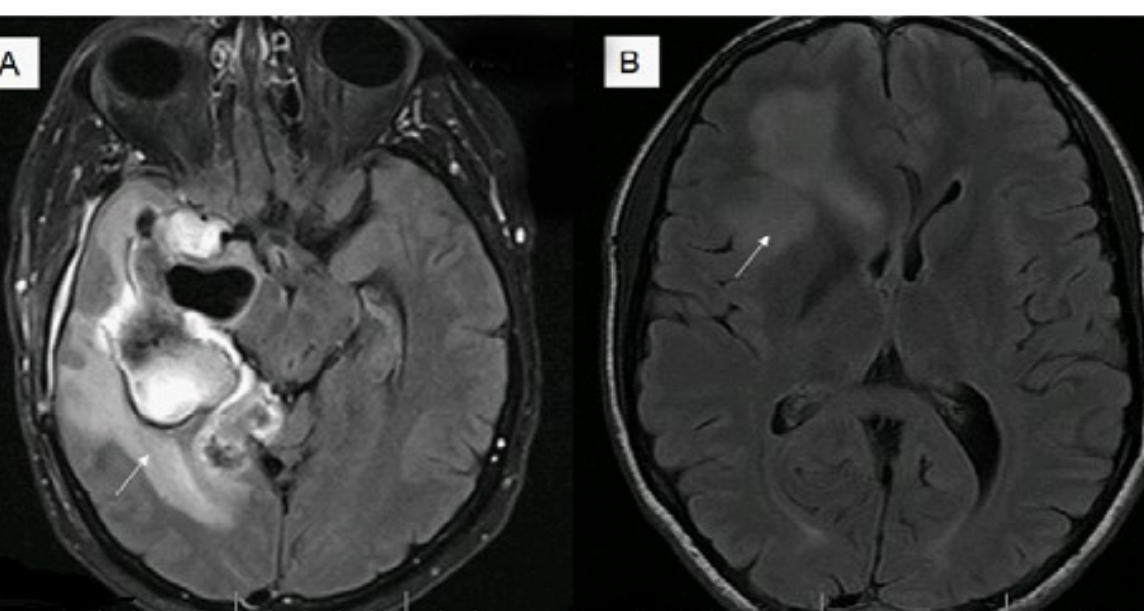
Figure 1. Magnetic resonance fluid attenuation inversion recovery (FLAIR) T2 imaging ( A ) of a 39 year old male, O(6)-methlyguanine-DNA-methyltransferase (MGMT) methylated glioblastoma (GBM) with increased edema (survival eight months post diagnosis); ( B ) 32 year old male, MGMT methylated GBM with less edema (alive seven years post